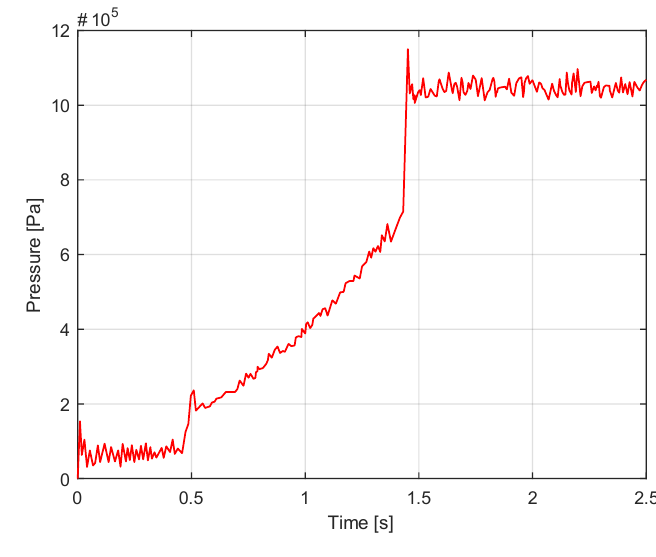
Figure 6 – Results of the experimental test Рис. 6 – Результаты экспериментального испытания Слика 6 – Резултати експерименталног